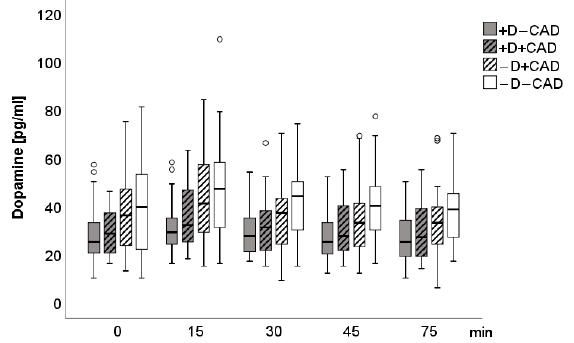
Figure 2. Boxplot of dopamine for each measurement time. Circle: ordinary outliner defined as one and a half boxlength, asterisk: extreme outliner defined as above one and a half to threefold box- length.